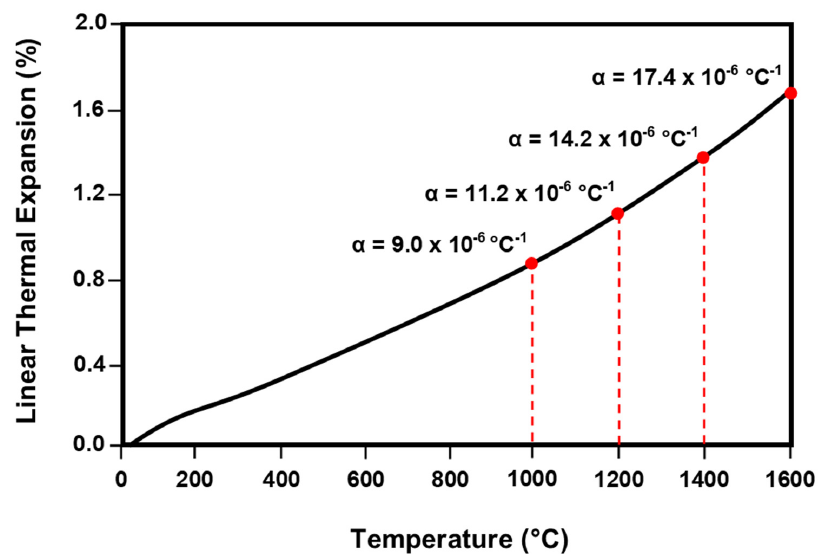
Figure 6. Optical dilatometry data for thermal expansion of percolated mullite from fly ash 2.